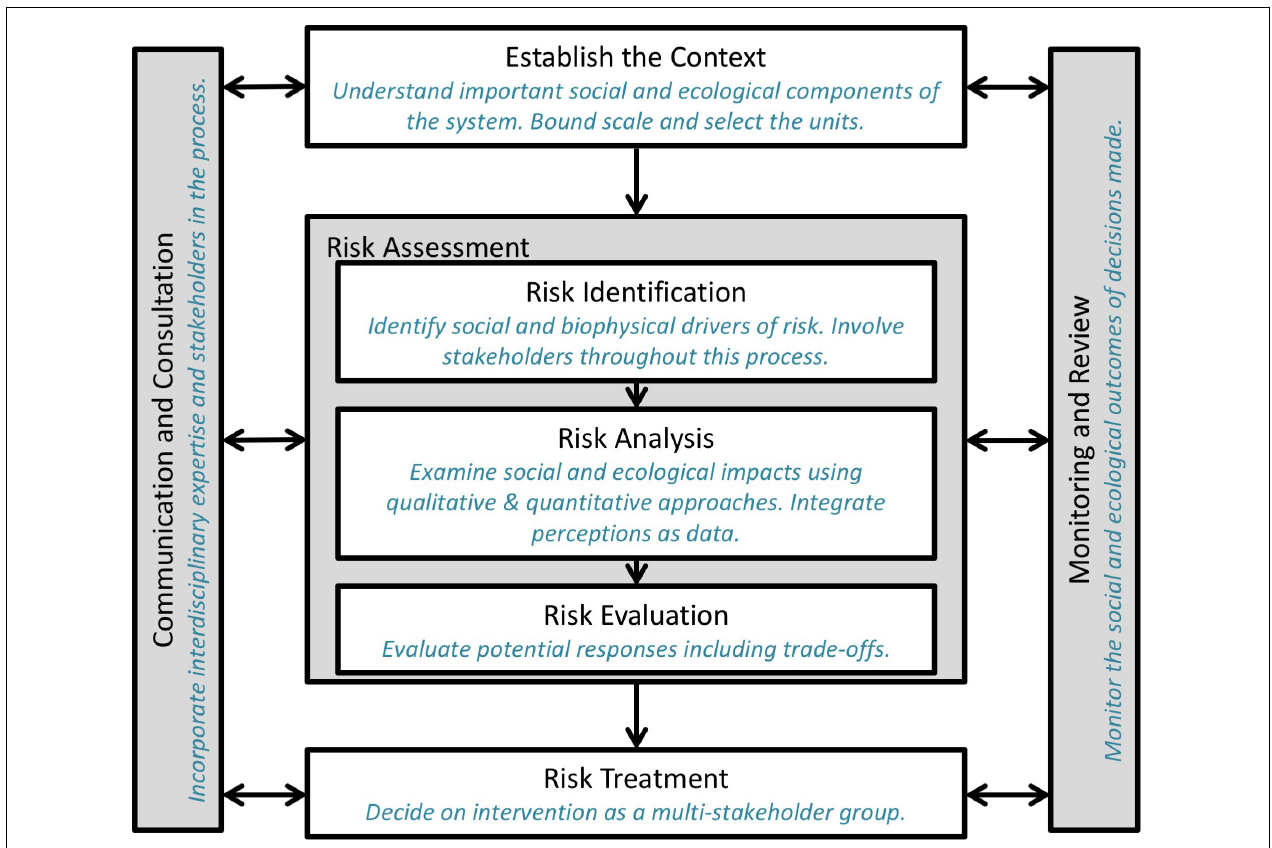
FIGURE 1 | Adapted from ISO Risk Assessment Standards (ISO, 2009), the traditional risk management framework. Text in italics has been added, and refers to the ways in which changes to this traditional process incorporate the insights from this